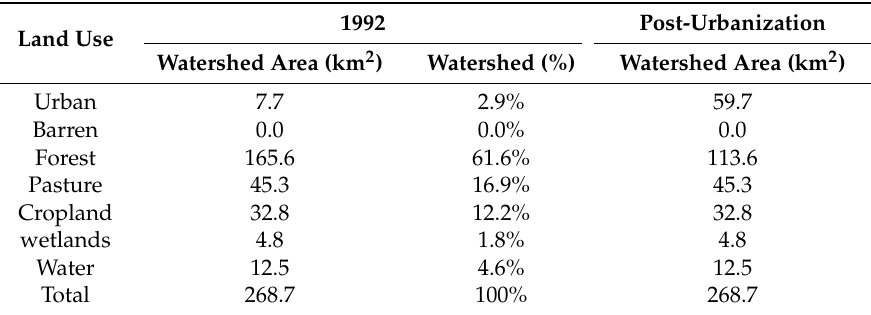
Comparison of 1992 multi-resolution land cover percentages within the Converse Watershed,